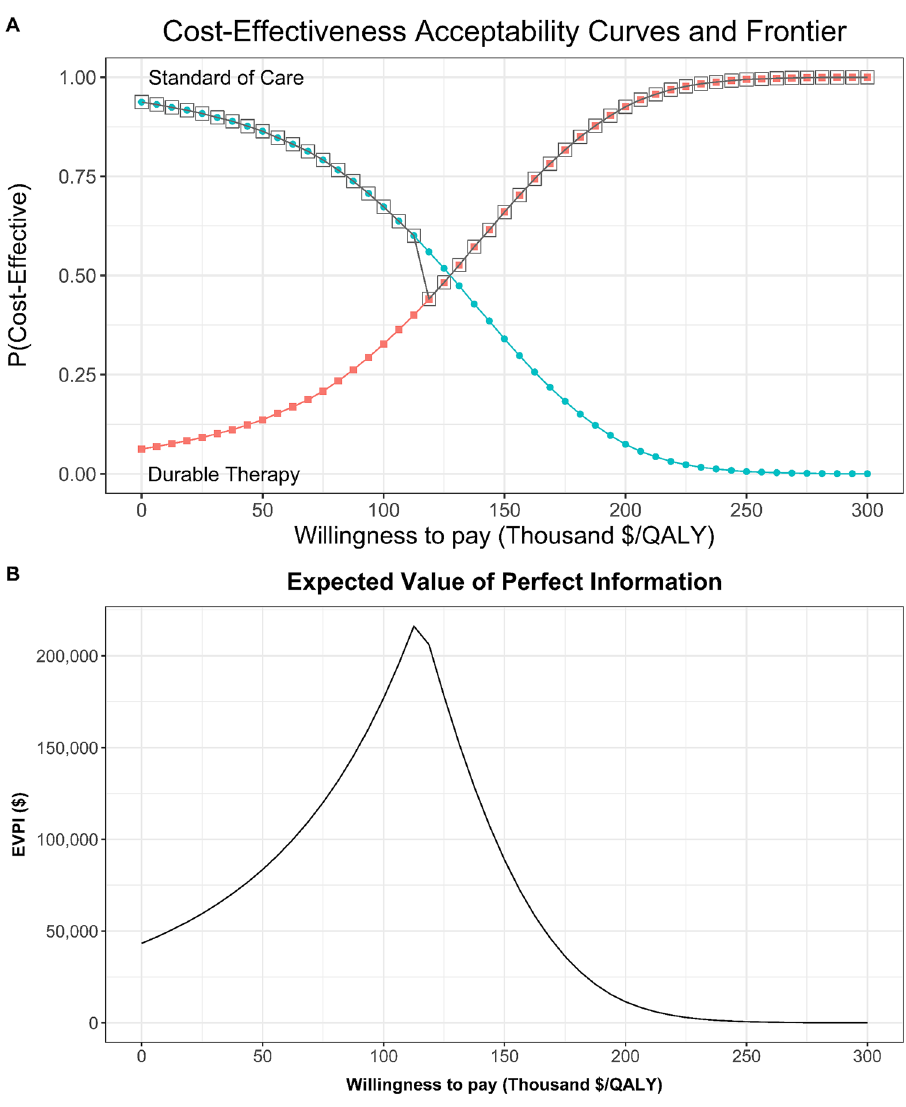
Figure 5. Probabilistic sensitivity analysis results. ( A ) Cost-effectiveness acceptability curves (CEAC) and frontier (CEAF). ( B ) Expected value of perfect information